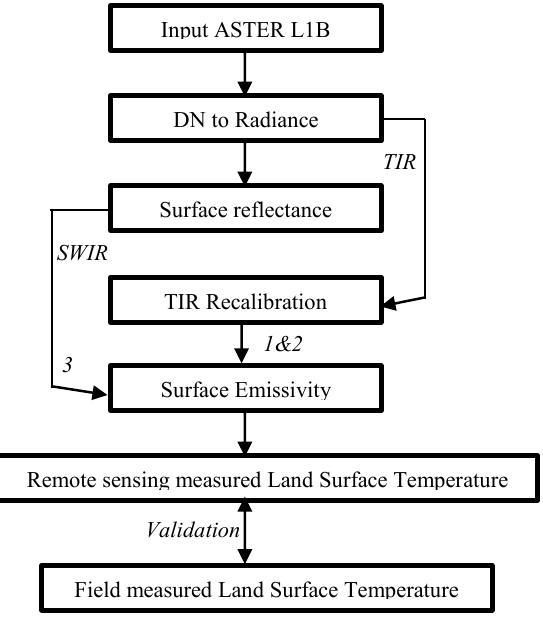
Figure 1. Represents methodology of this